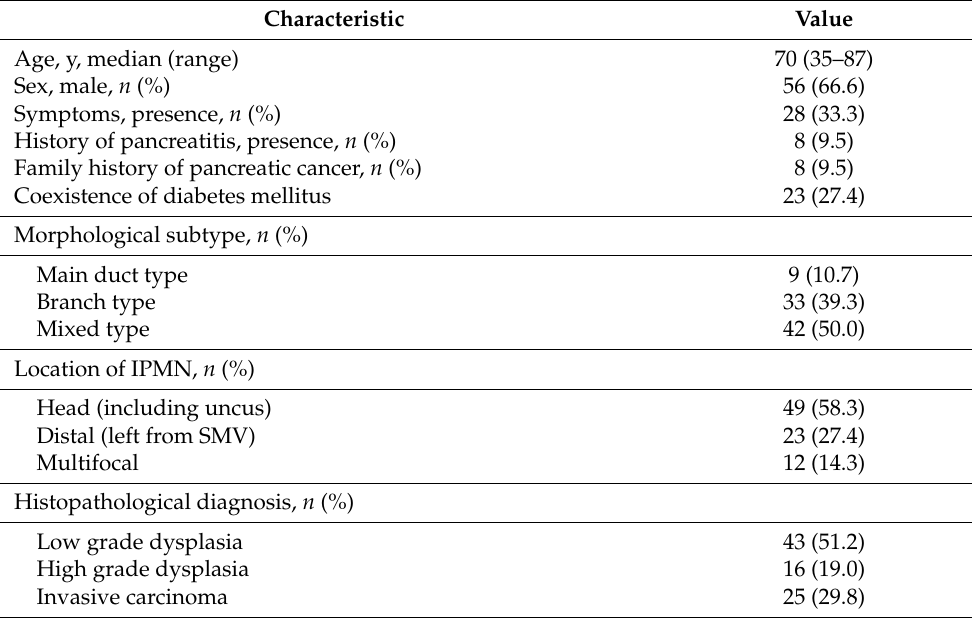
Table 1. Patient background characteristics ( n =